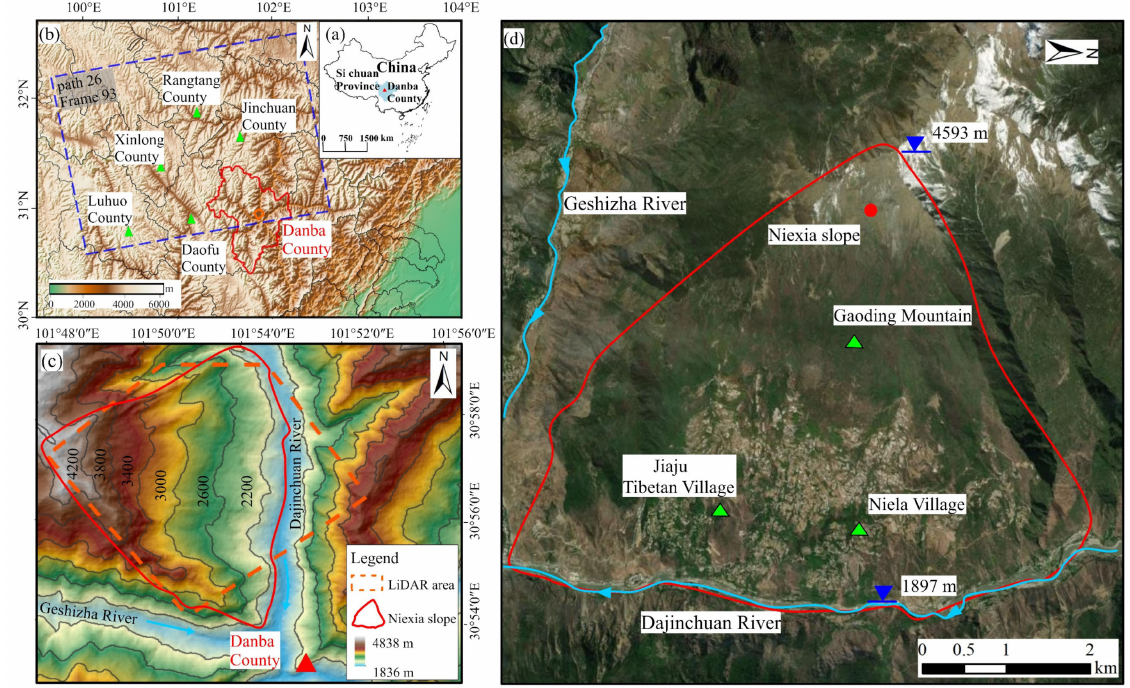
Figure 1. ( a ) Danba County basic location; ( b ) SAR image coverage and basic location of the study area; ( c ) optical image covering the study area; ( d ) topographic and elevation information of the study area.